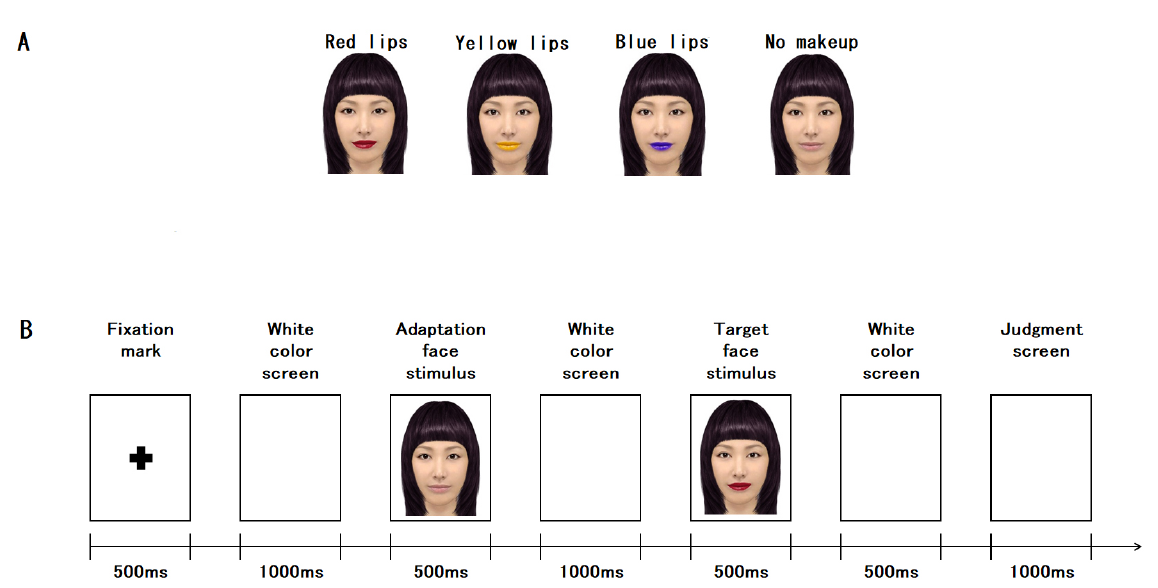
Fig. 1. Example of stimuli and the single trial. (A) Examples of four face stimuli. (B) Timeline of the single trial. This figure has been modified from Tanaka